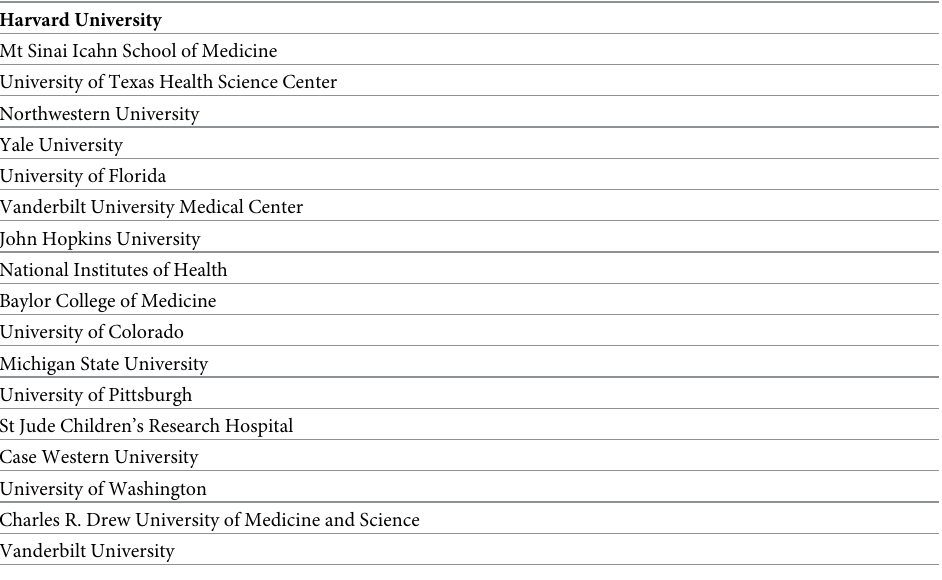
Table 6. Postdoctoral institutions for IMSD students upon PhD